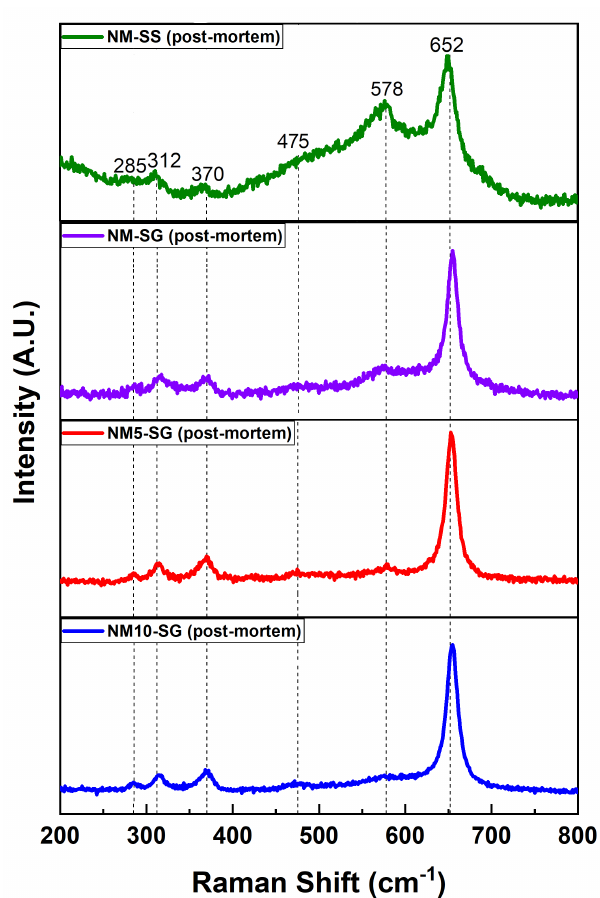
Figure 7. Post mortem Raman spectra of the electrodes after 20 charge/discharge